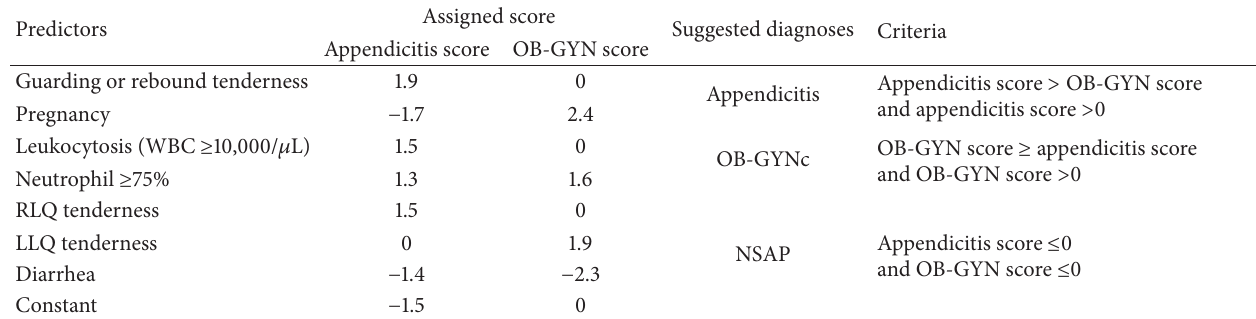
Table 1: The scoring scheme for appendicitis and obstetrics-gynecological conditions (OB-GYNc) and the criteria used to guide diagnosis of abdominal pain caused by appendicitis, obstetrics, and gynecological conditions (OB-GYNc) or nonspecific abdominal pain